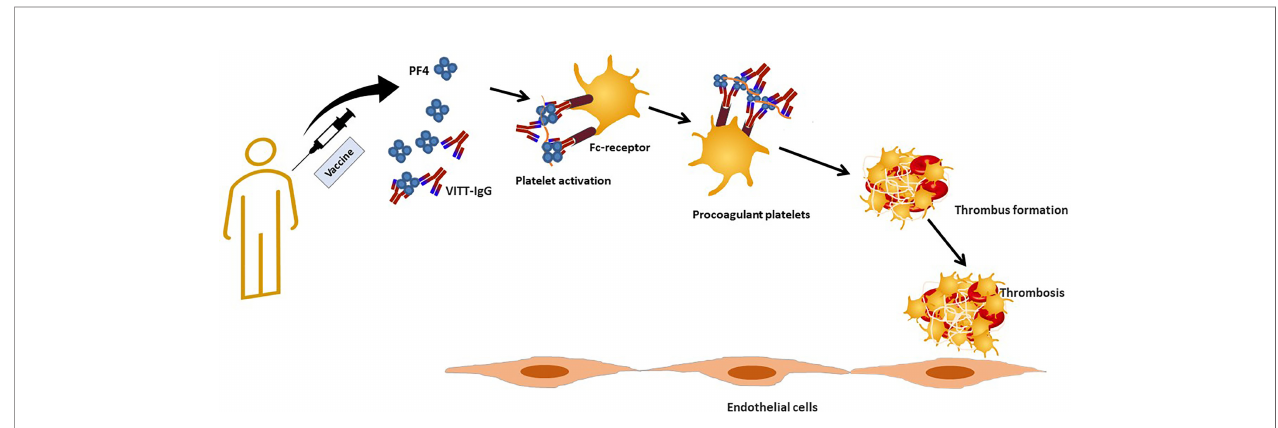
FIGURE 2 | Proposed pathologic events in vaccine induced immune thrombotic